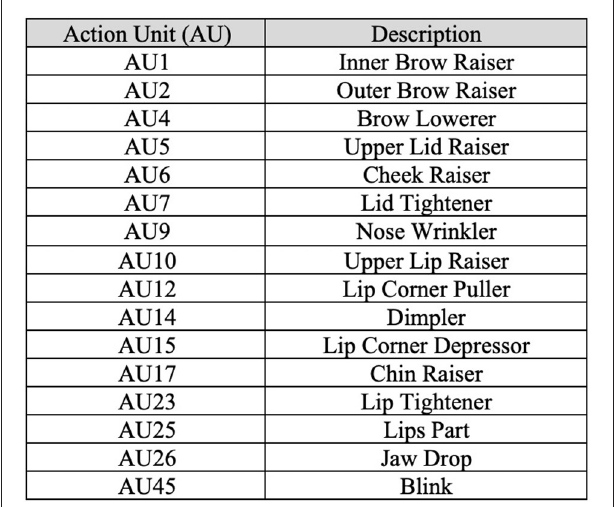
FIGURE 1 | Collected AUs with their associated